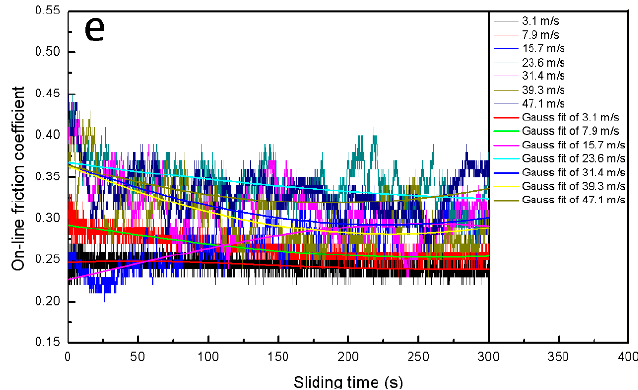
Figure A1. The on-line friction curves of each PF composite: ( a ) 0Gr; ( b ) 10Gr; ( c ) 20Gr; ( d ) 25Gr; ( e ) 30Gr.